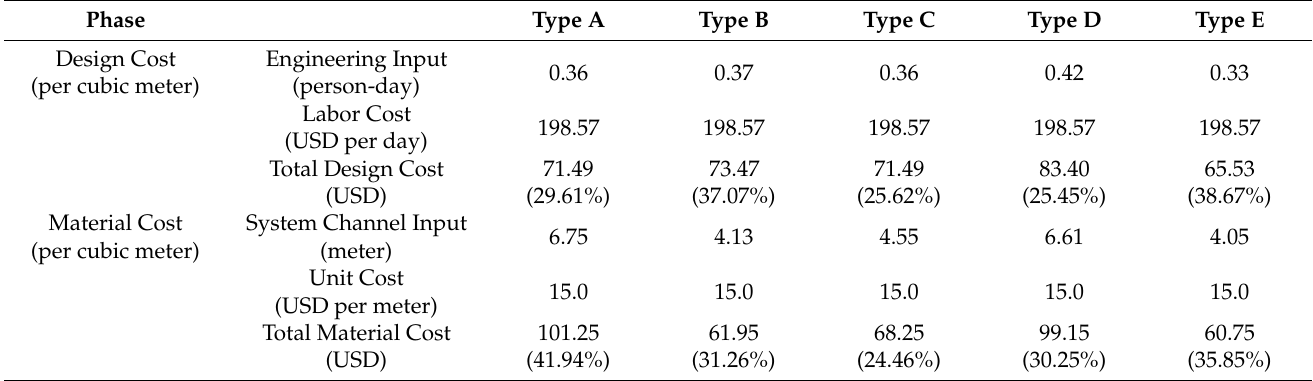
Table 2. Results of economic